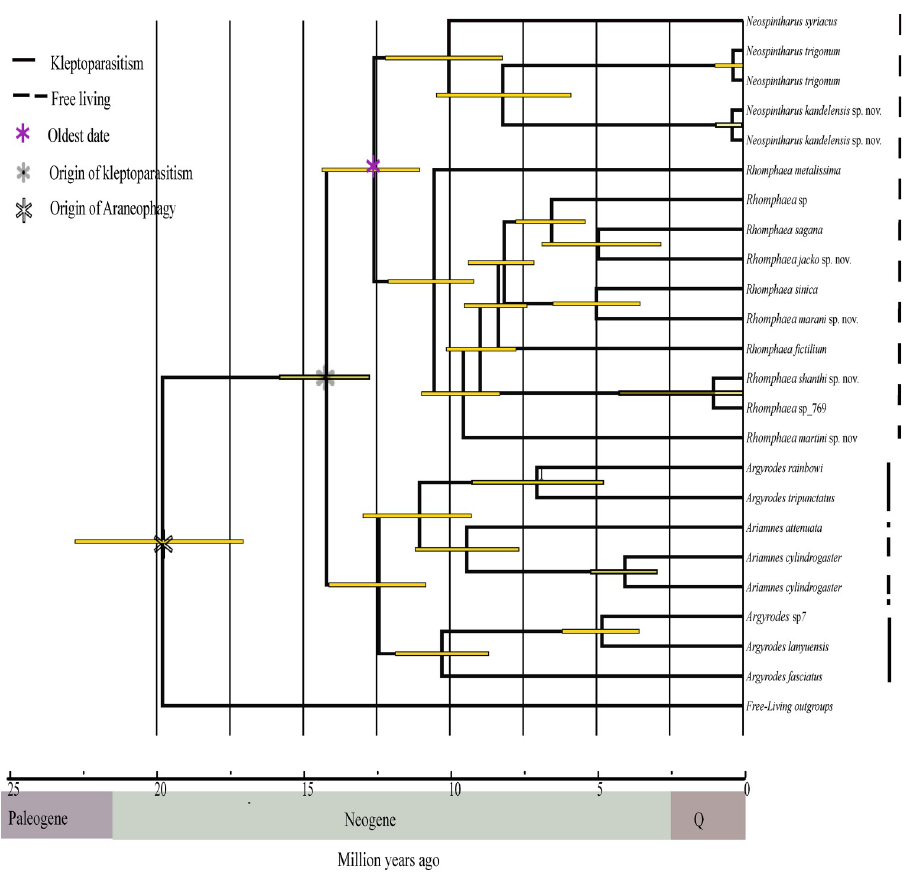
Fig 3. A divergent time calibrated phylogeny estimated in BEAST. Times of origination using the age of the oldest date extracted from a previous study [20]. Placement of oldest date marked as purple asterisk on the node. The yellow bar on the node shows the 95% highest probability density interval of the estimated